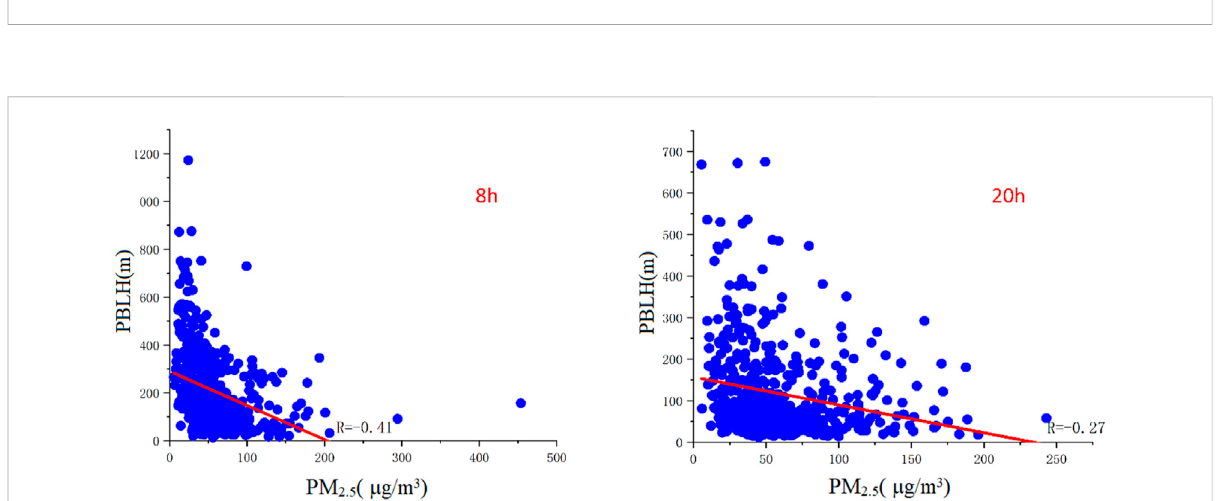
FIGURE 4 Correlation between PBLH and PM 2.5 concentration in Changsha at 08:00 (BJT) and 20:00 (BJT) when R > 0.245 (under the recirculation wind fi